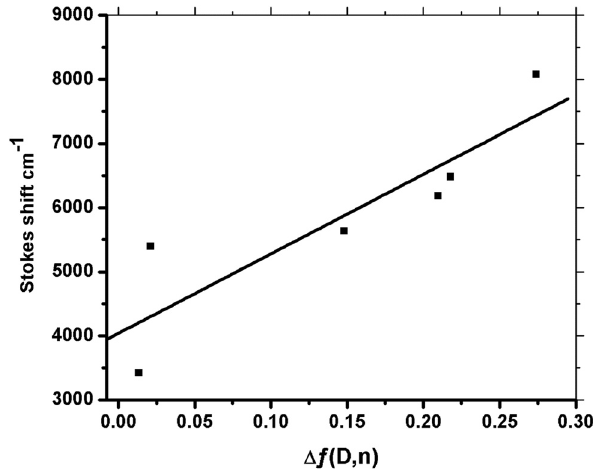
Figure 4: Plot of Δ F vs Stokes shift ( cm − 1 ) .